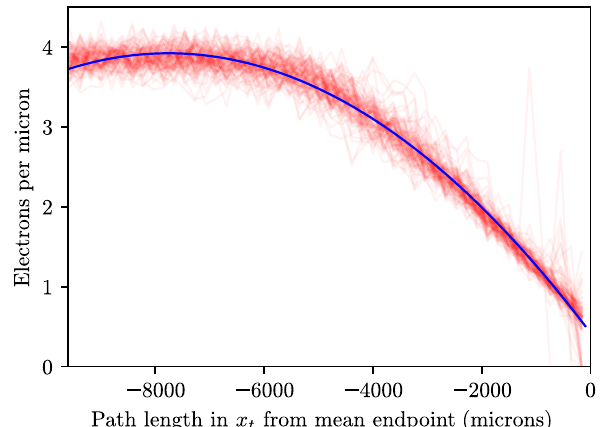
Fig. 3 A parameterization of the Bragg curve (solid blue line) fitted to the linear charge density λ of simulated alpha recoils (semi-transparent red lines), calculated as the number of electrons per micron in 192 µ m bins for 100 1MeV alpha recoils simulated with SRIM, projected onto the axis of the initial momentum vector of the recoil ( x t ). The parame- terization uses a second-order Chebyshev series, with x t = 0 set to the mean endpoint of all